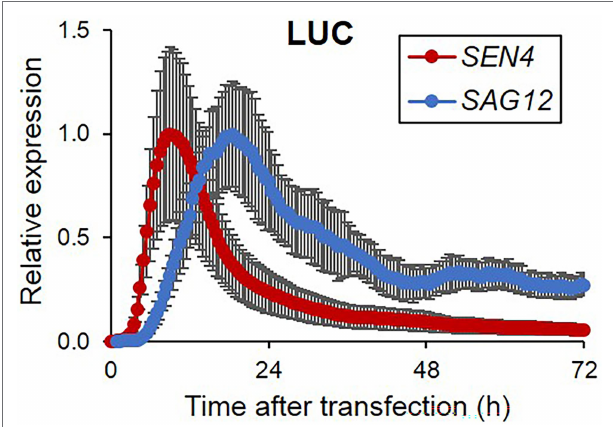
FIGURE 1 | Bioluminescence expression patterns of luciferase reporters controlled by senescence-associated promoters in Arabidopsis protoplasts during darkness. Bioluminescence traces in Arabidopsis protoplasts expressing a firefly luciferase gene ( LUC ) driven by SEN4 and SAG12 promoters ( SEN4 - and SAG12-LUC ) and a Renilla luciferase (RLUC) driven by 35S promoter (35S-RLUC) in darkness after transfection are shown. Image acquisition was performed every 30 min for 3 d. Luciferase activity of LUC was normalized to the maximum level of RLUC over the assay. Each data set was normalized to the maximum level of LUC/RLUC throughout the measurement. Data represent mean ± SE ( n = 3). Similar results were obtained in two independent